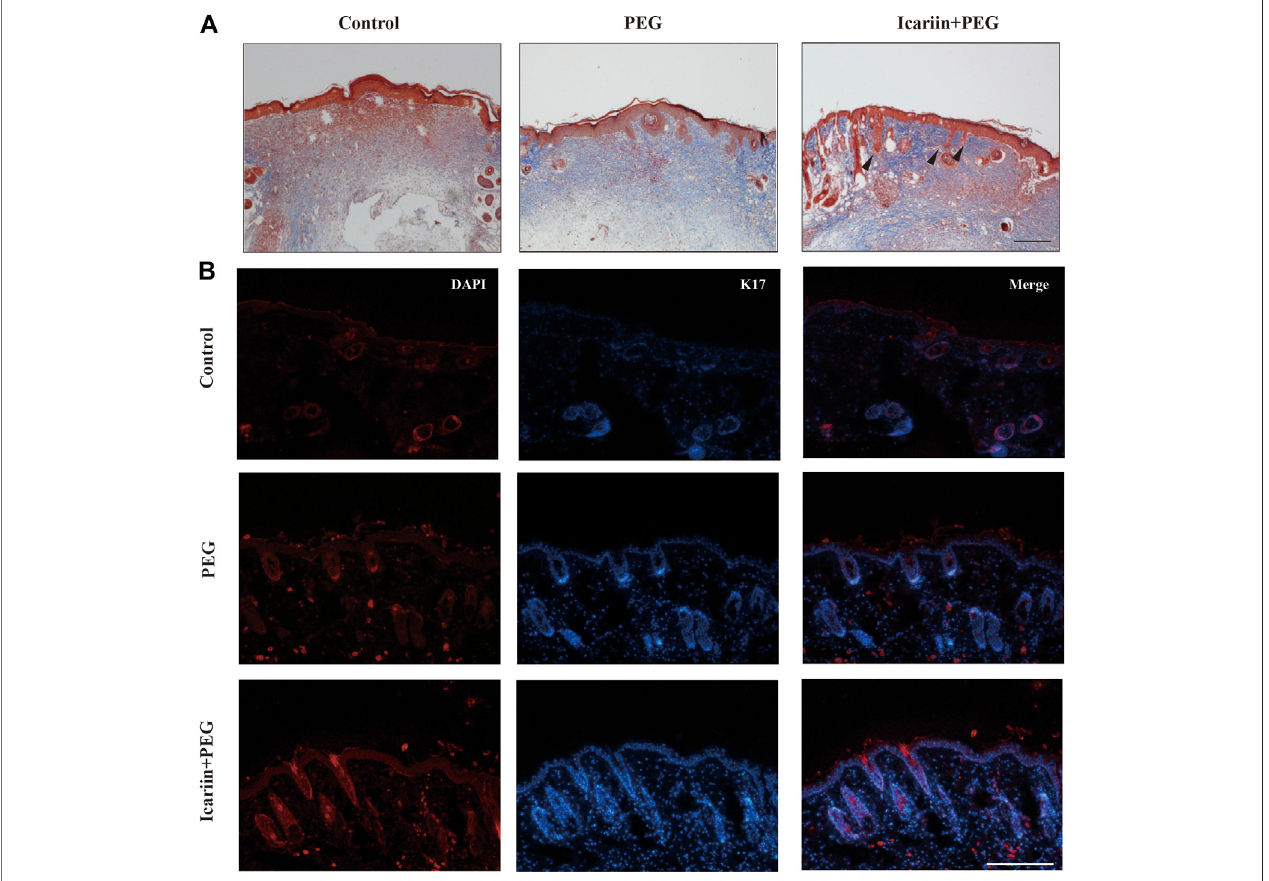
FIGURE 5 | Hair follicles are regenerated with icariin+PEG hydrogel treatment. (A) Masson staining of different groups on day 14. Red arrows indicate new hair follicles. Scale bar: 200 μ m. (B) Representative immuno fl uorescence images of K17 expression on day 14 at the injured sites. Scale bar: 100 μ m.